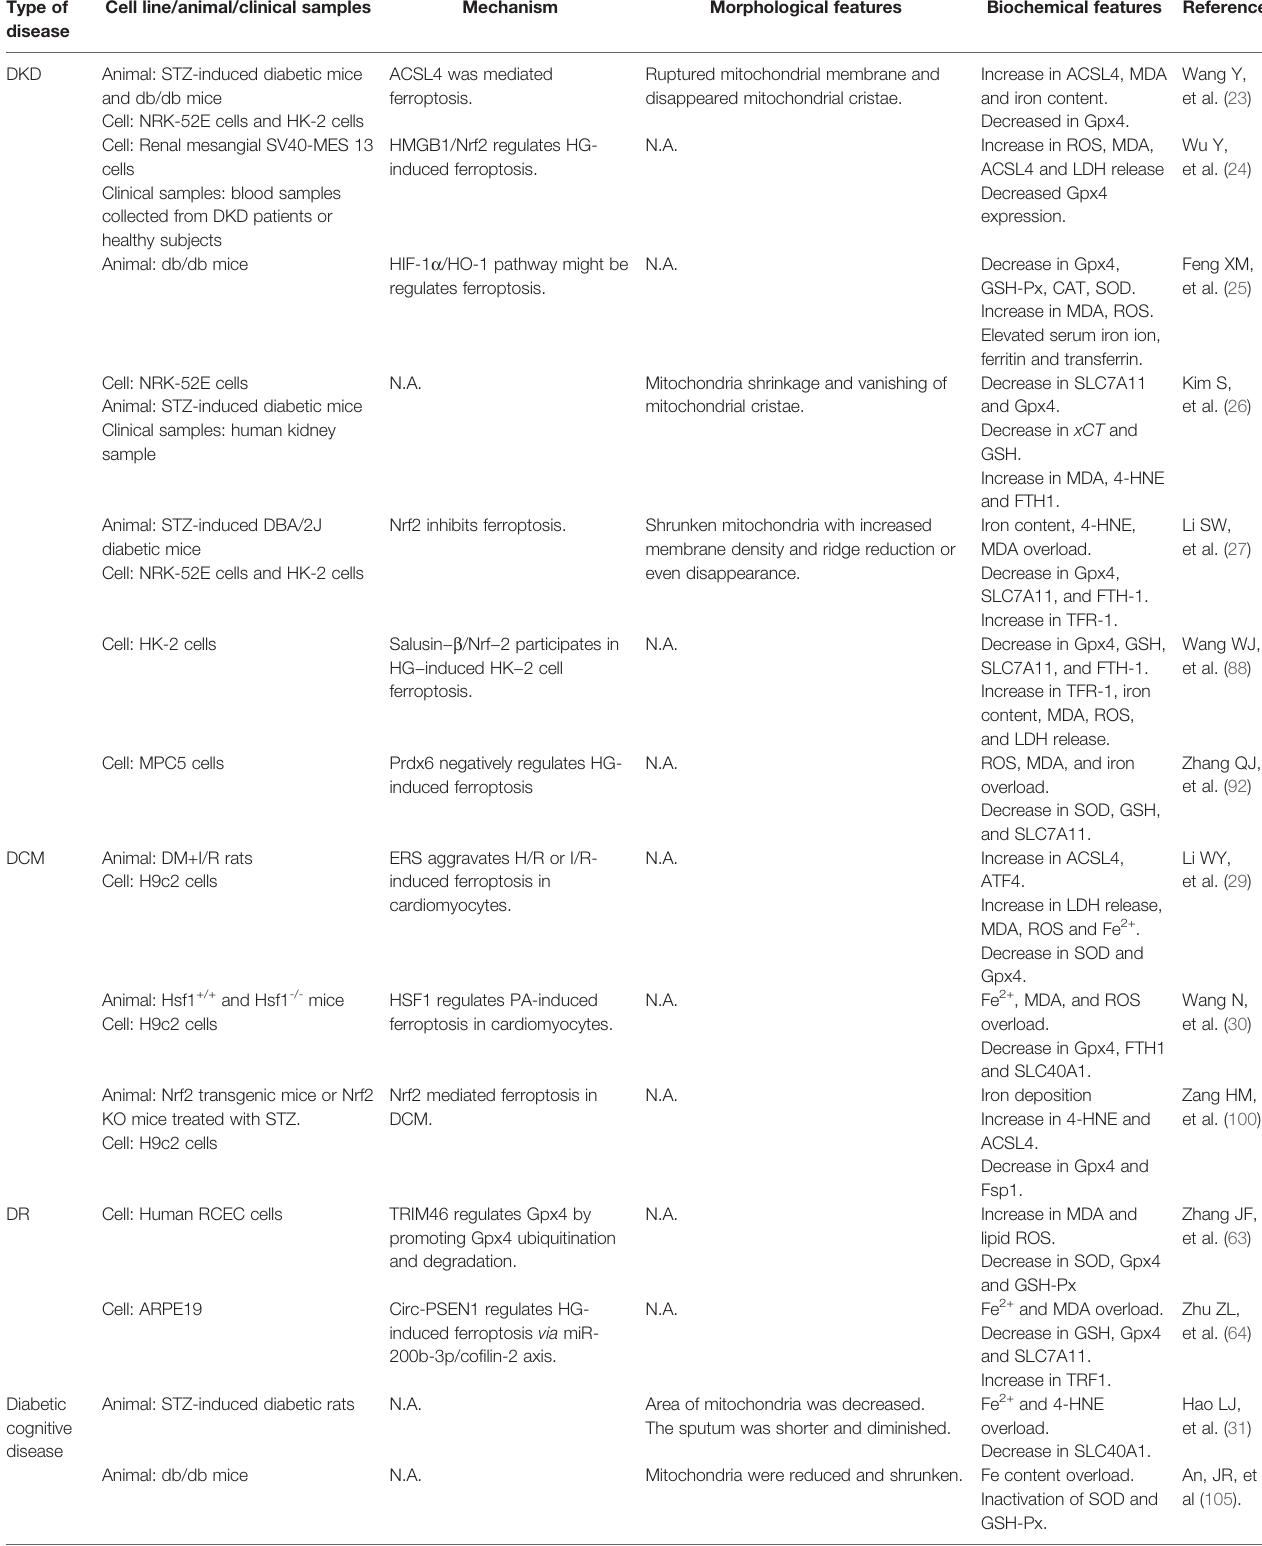
TABLE 1 | The main regulatory mechanism, morphological and biochemical feature of ferroptosis in diabetes and related complications. Type of